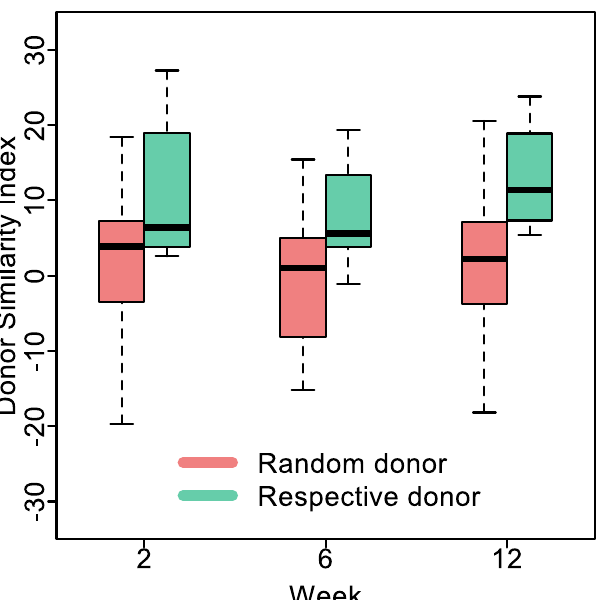
Fig 4. Patient microbiomes became more similar to their respective donors than random donors. Boxplots of the DSI for patients with positive DSI scores compared with their respective donor (green) are shown at 2, 6 and 12 weeks. The boxplots of patients compared with random donors (all donors excluding their own) are also shown (red). The mean DSI for patients compared to their respective donors was 11.8 ± 10.8, 8.2 ± 8.1 and 13.4 ± 7.8, and the DSI when compared to all other donors was 1.6 ± 9.6, -0.7 ± 8.0 and 2.5 ± 8.7 at 2, 6 and 12 weeks, respectively. (Fig 3b). All post-FMT scores for four of the patients (1, 6, 7, and 13) were positive. The three patients with negative DSI at two weeks had positive DSI at six weeks. The largest DSI of 27.2%